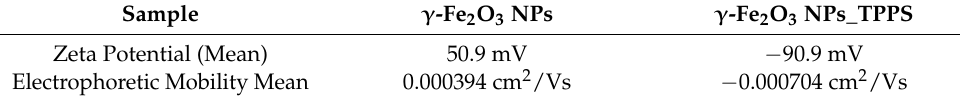
Table 3. Zeta potential values for the γ -Fe 2 O 3 NPs and γ -Fe 2 O 3 NPs_TPPS samples